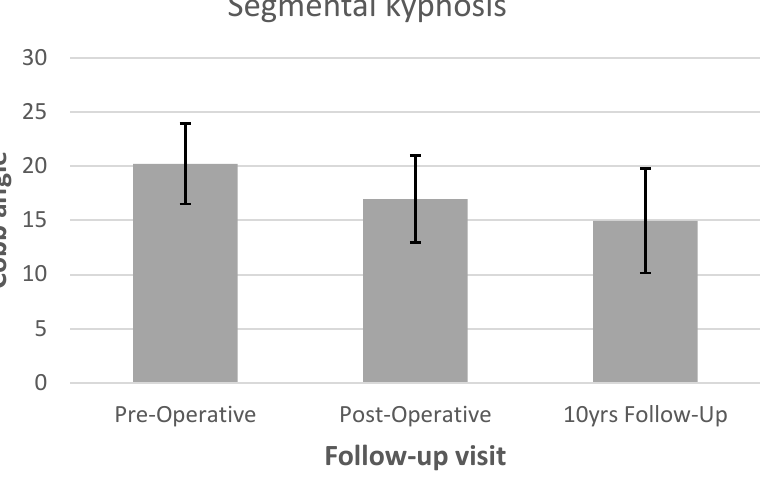
Figure 4. Pre-operative, immediate post-operative and 10 years follow-up segmental kyphosis level. Case